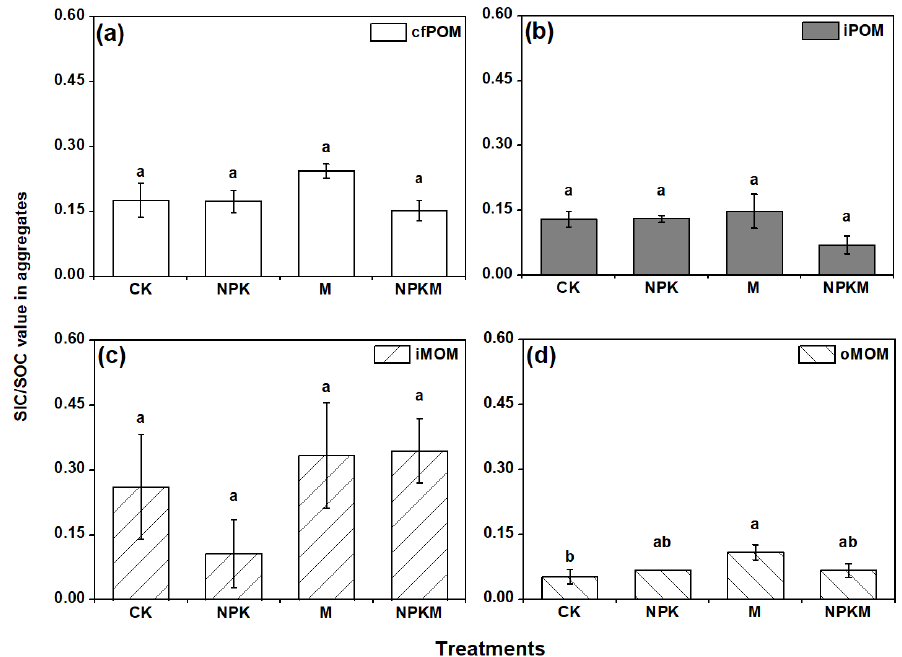
Figure 4. The value of SIC/SOC in different aggregates: ( a ) cfPOM; ( b ) iPOM; ( c ) iMOM; ( d ) oMOM. cfPOM means coarse free particulate organic matter fraction, iPOM means particulate organic matter inner microaggregate, iMOM means mineral-associated organic matter inner microaggregate, and oMOM means mineral-associated organic matter outer fraction. Error bars represent the standard deviations of the mean ( n = 3). Different characters above bars indicate significant differences among the treatments at p <